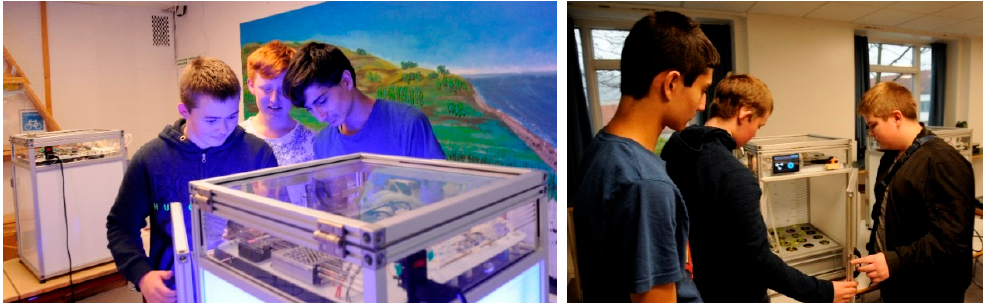
Figure 17. Two groups of the school pupils interacting with the GrowBot during the 8 weeks intervention at the school Tinderhøj Skole, in Denmark.